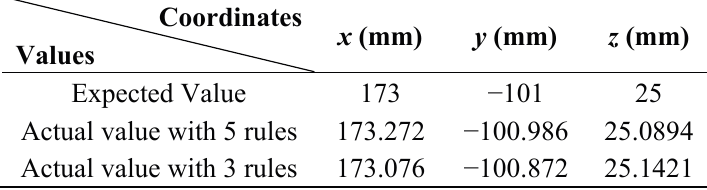
Table 1. Simulation results of position control: test point (173, − 101, 25).